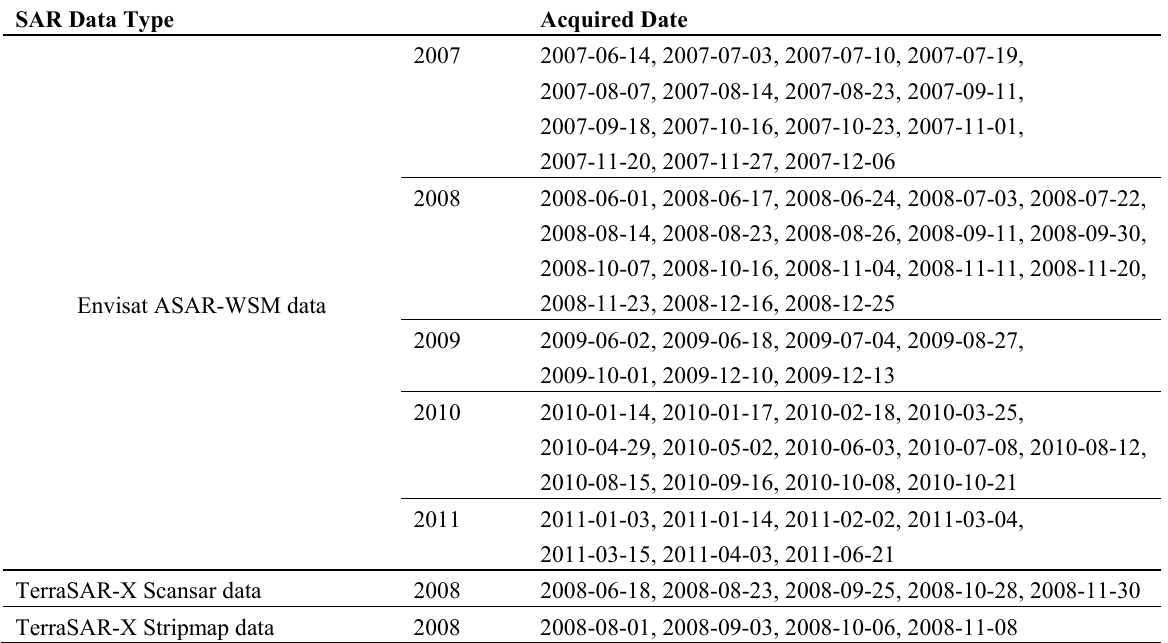
Table 1. Envisat ASAR-WSM and TerraSAR-X Scansar and Stripmap mode SAR data employed for data analyses for Can Tho